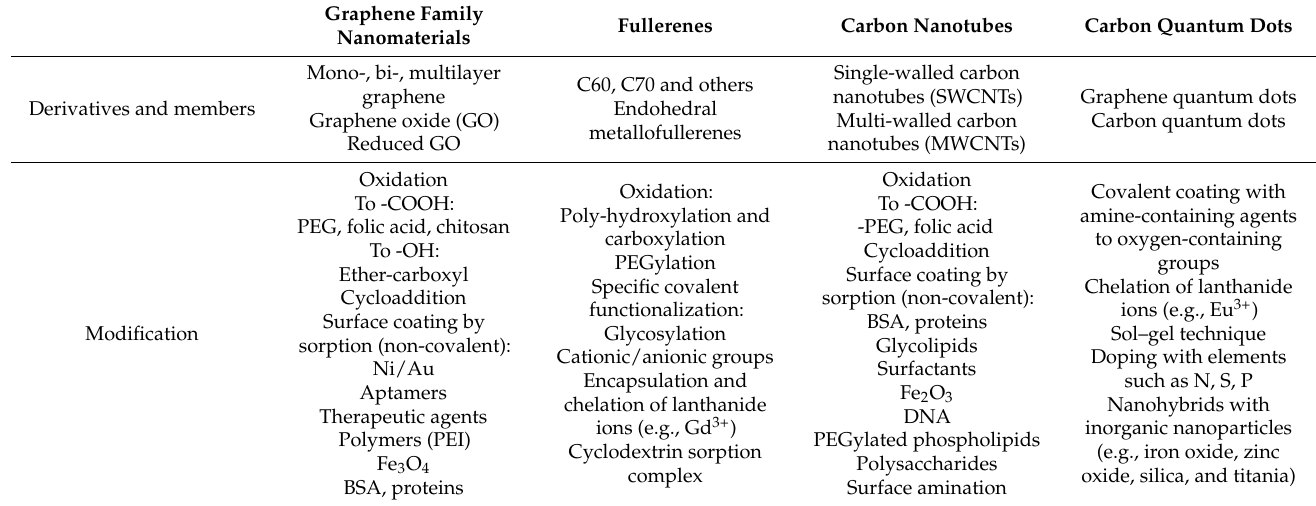
Table 1. Various forms of carbon nanostructure, their derivatives, alterations, and theranostics applications. Graphene Family